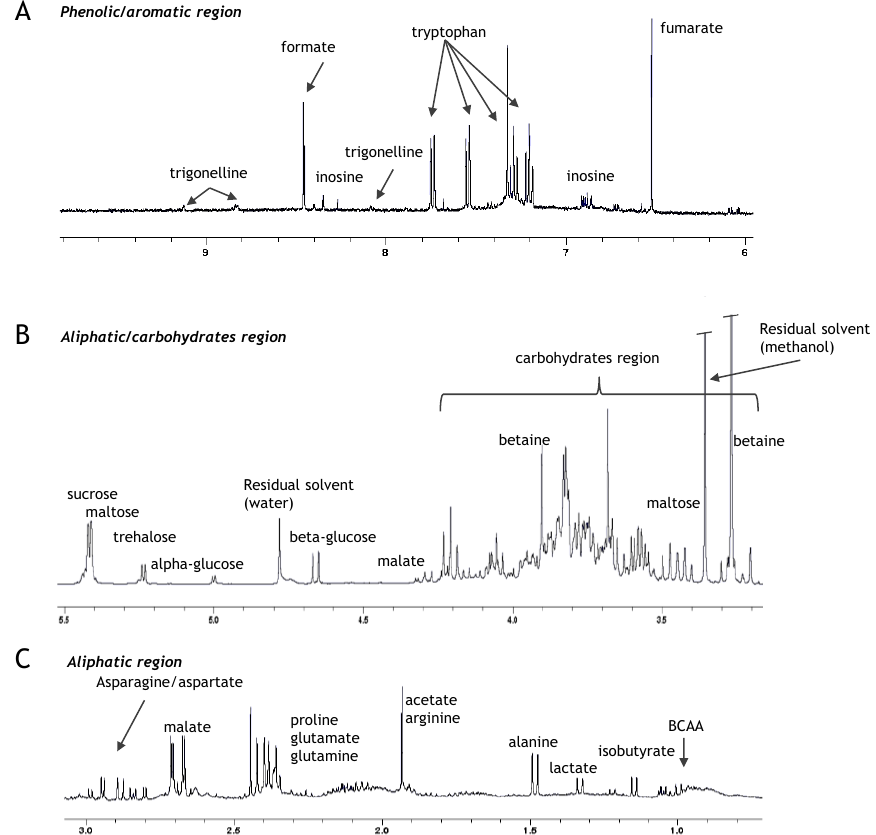
Figure 3. ( A ) from 10 to 6.00 ppm, ( B ) from 5.5 to 3.00 ppm and ( C ) from 3.00 to 0.5 ppm spectral regions for a 600 MHz 1 H NMR spectrum from a Svevo aqueous extract, referenced to TSP (δ 0.00 ppm). ( A – C ) expansions indicate the aromatic/phenolic, carbohydrates and aliphatic spectral regions, respectively; BCCA: branched-chain amino acids.